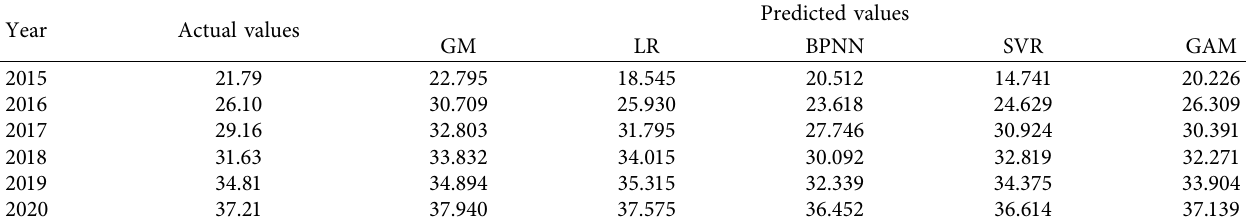
Table 2: Actual and predicted